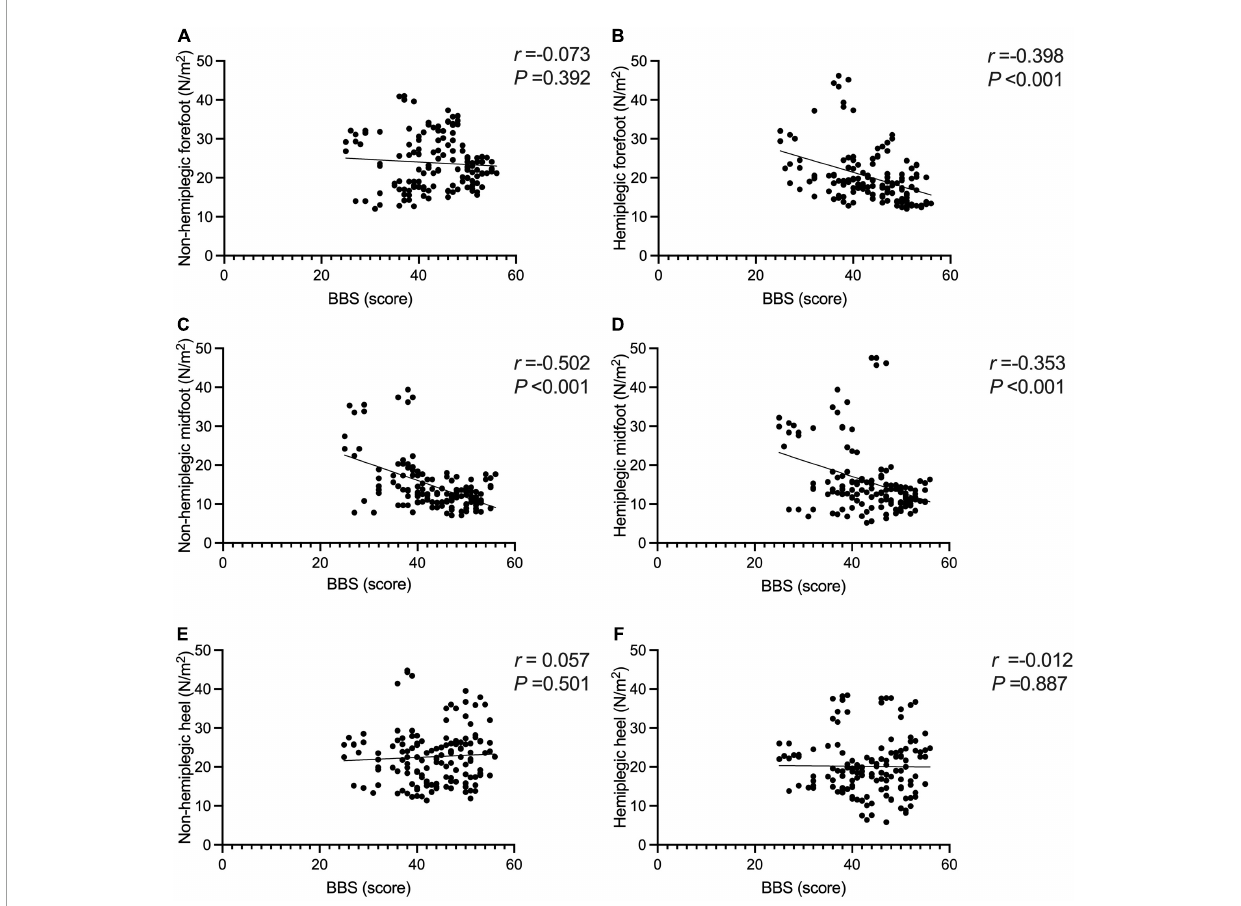
FIGURE8 Correlations between the Berg Balance Scale score and peak plantar pressure in the study group. The BBS score was not correlated with the peak plantar pressure of the non-hemiplegic forefoot (A) ( P > 0.05), but it was negatively correlated with the peak plantar pressure of the hemiplegic forefoot (B) ( r = − 0.398, P < 0.001). The BBS score was negatively correlated with the peak plantar pressure of the non-hemiplegic midfoot (C) ( r = − 0.502, P < 0.001) and the hemiplegic midfoot (D) ( r = − 0.353, P < 0.001). The BBS score was not correlated with the peak plantar pressure of